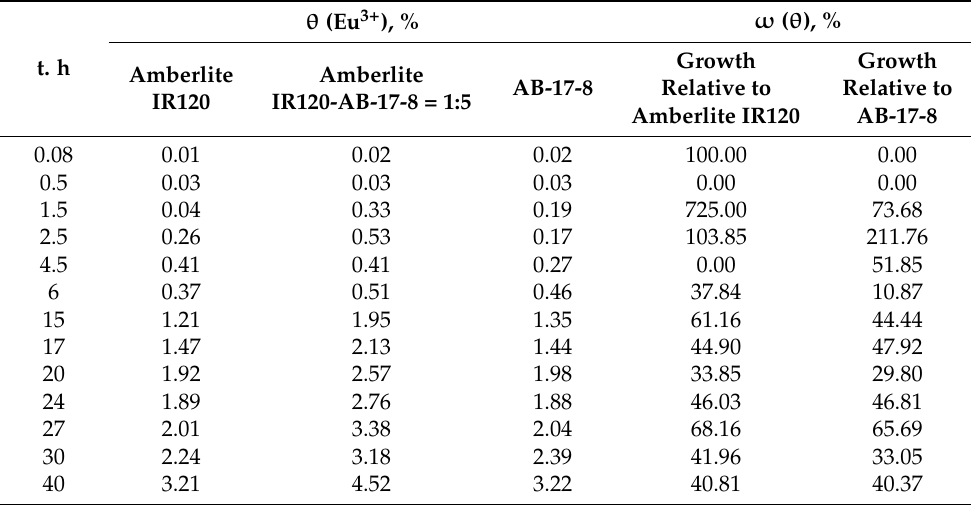
Table 5. Increase of polymer chain binding degree in interpolymer pair Amberlite IR120:AB-17-8 = 1:5 compared with individual ion